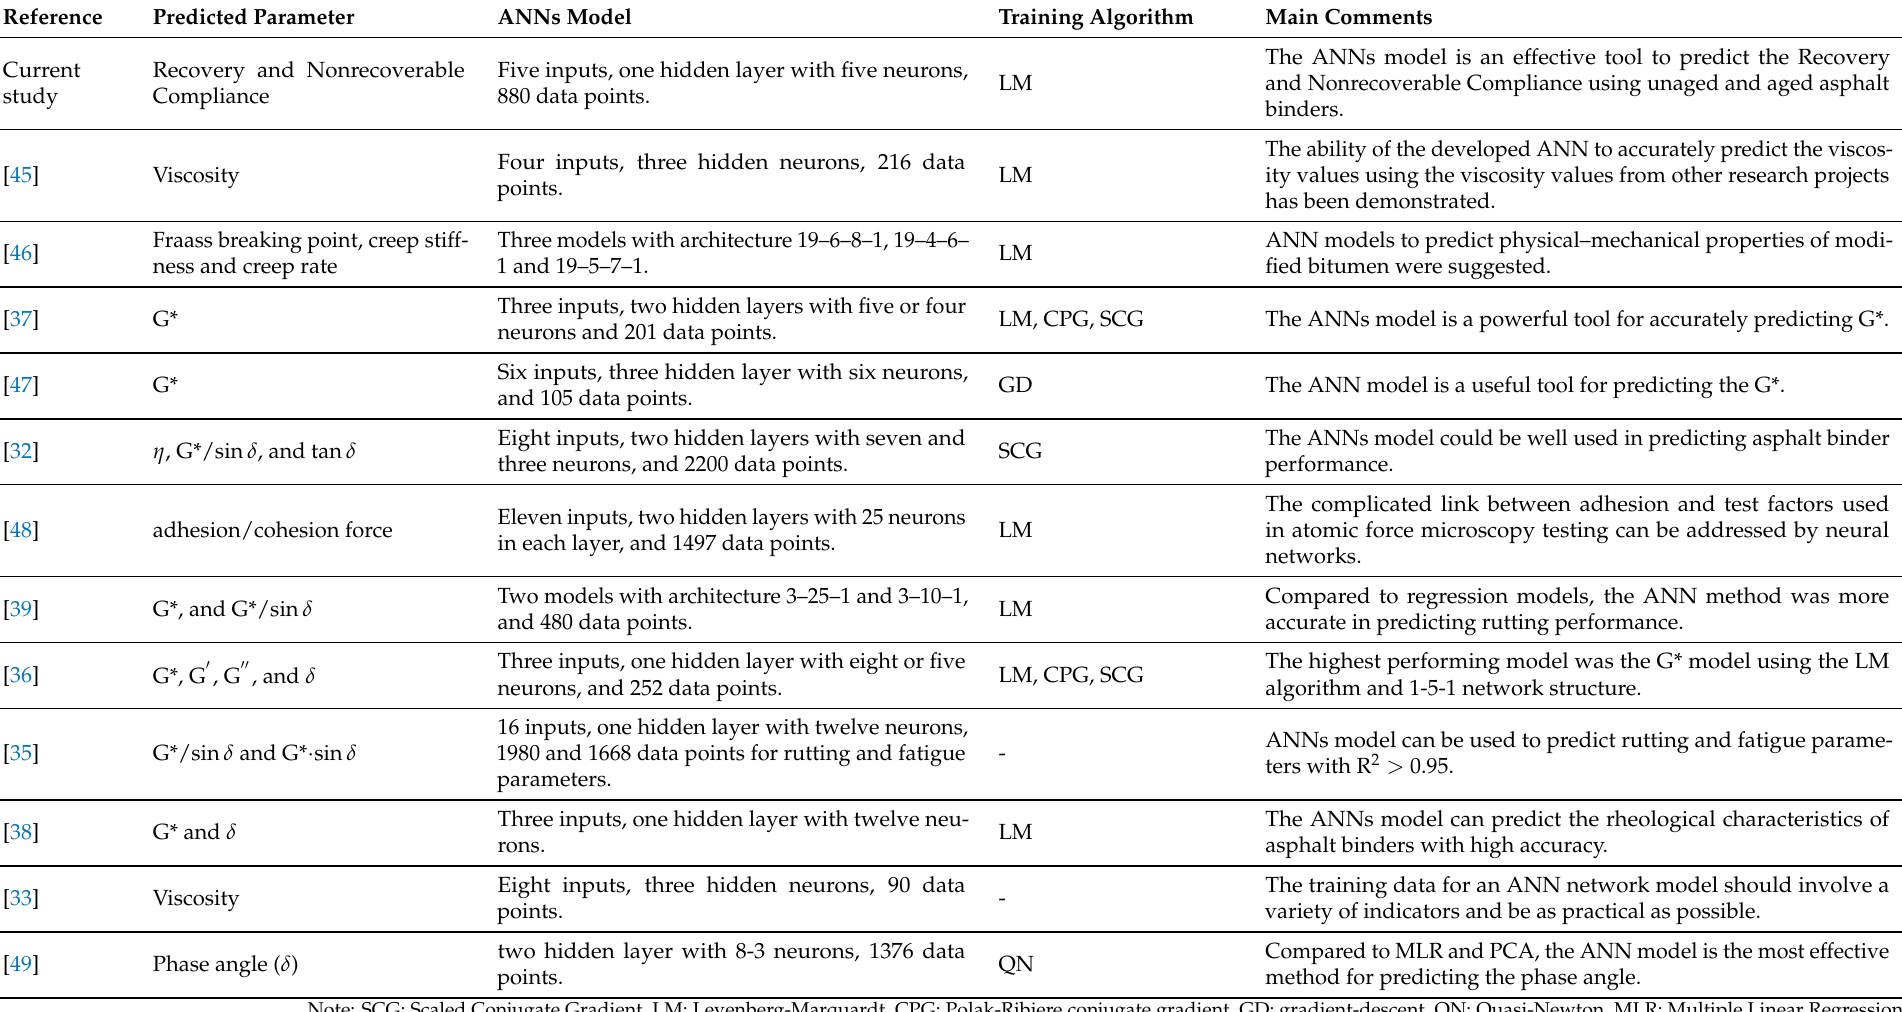
Table 2. Predicting the rheological and performance properties of asphalt binder using ANNs